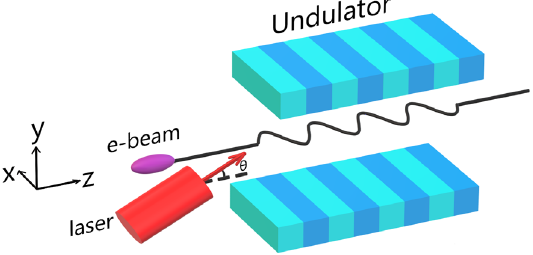
FIG. 1. Schematic view of the sinelike trajectory of the electrons and of the oblique incidence with a small angle θ of the electromagnetic plane wave in a planar undulator. The laser field is polarized in the horizontal